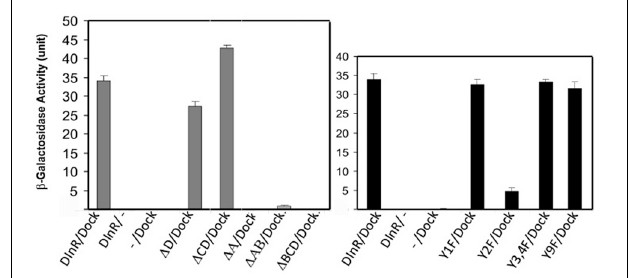
FIGURE 2 | Yeast two-hybrid assays identify candidate Dock interaction sites in the DInR C-tail. pACT-Dock was tested for interaction with pAS2.1 containing the DInR intracellular domain or variants thereof, as indicated. β -galactosidase activity is shown. Negative controls: pAS2.1-DInR with empty pACT ( − ); empty pAS2.1 ( − ) with pACT-Dock. Error bars indicate standard deviation.